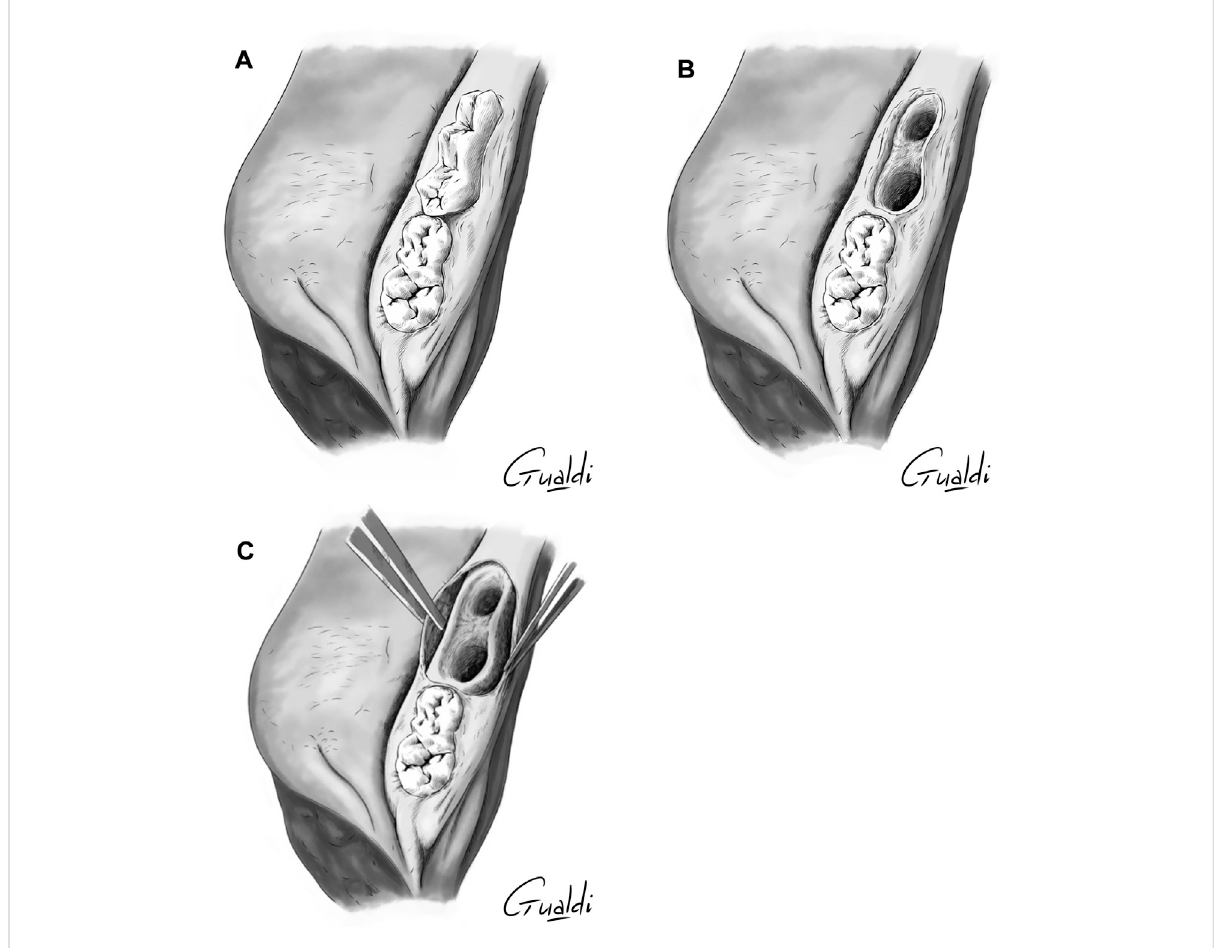
FIGURE 1 Simulation ofMRONJonporcine mandiblespecimen(upperviewillustration): (A) Beforepremolarextraction; (B) Afterpremolarextraction; (C) After gingival detachment from the alveolar